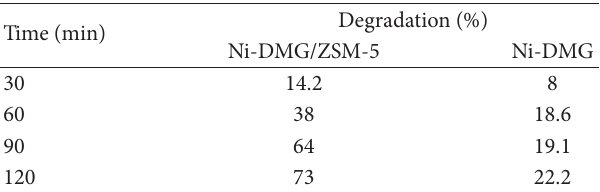
T2: Comparisonofthephotocatalytic activity ofsupported and unsupported